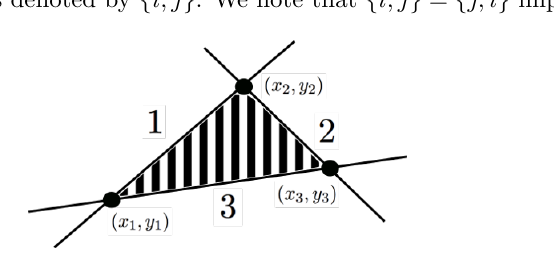
Figure 2 . A triangle in a(cid:14)ne space de(cid:12)ned by vertices ( x i ; y i ), with faces (edges) labeled by i corresponding to the points f Z (cid:11) g 1 (cid:20) i (cid:20) 3 in the dual space that de(cid:12)ne them. The Z (cid:11) i de(cid:12)ned in terms of the ( x i ; y i ) coordinates in the